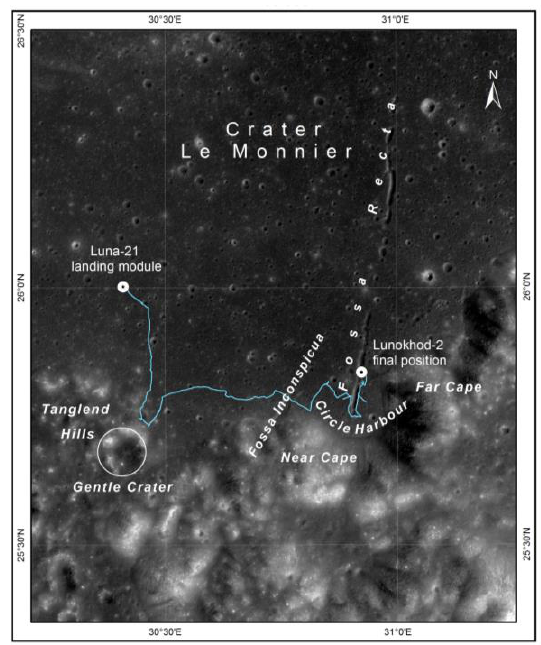
Figure 1. Map of Lunokhod-2